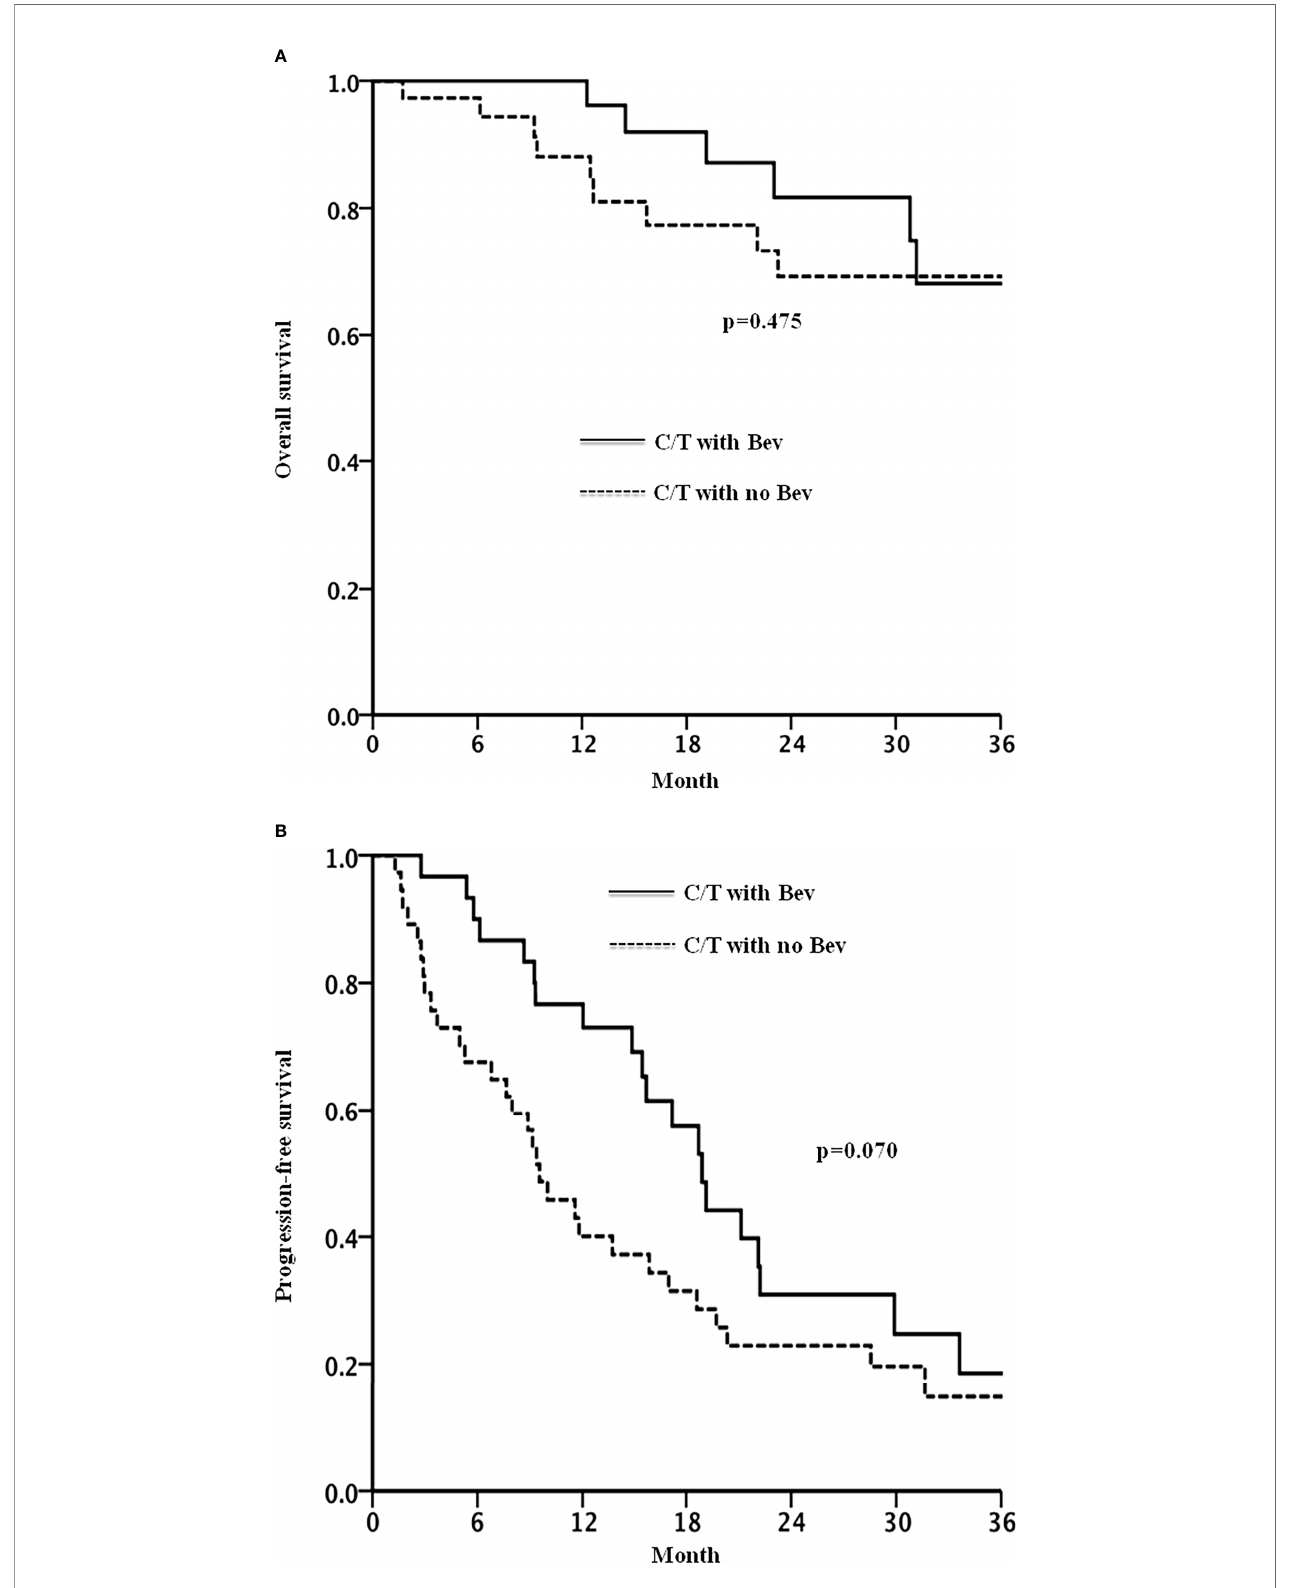
FIGURE 2 | Overall survival (A) and progression free survival (B) in patients with recurrent ovarian cancer treated with chemotherapy with or without